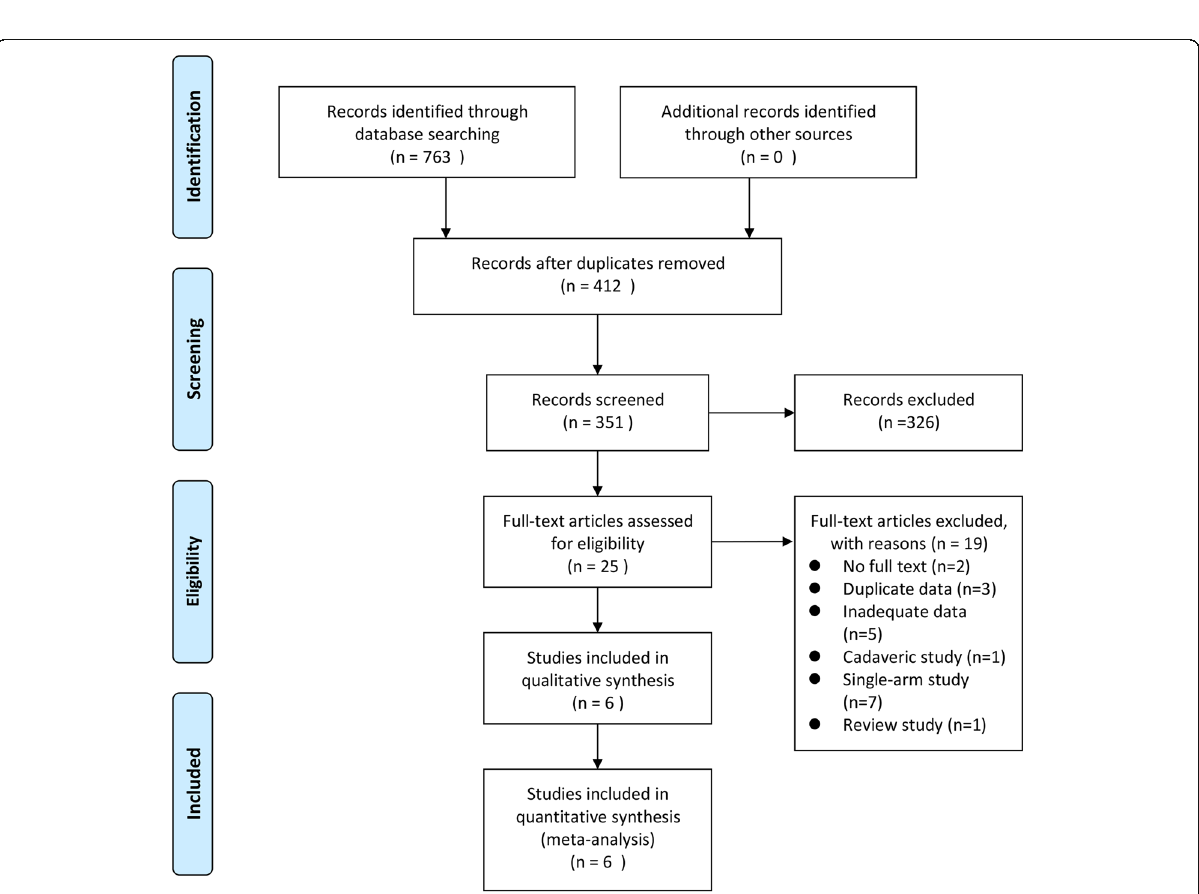
Fig. 2 Flow diagram of the study identification and selection process